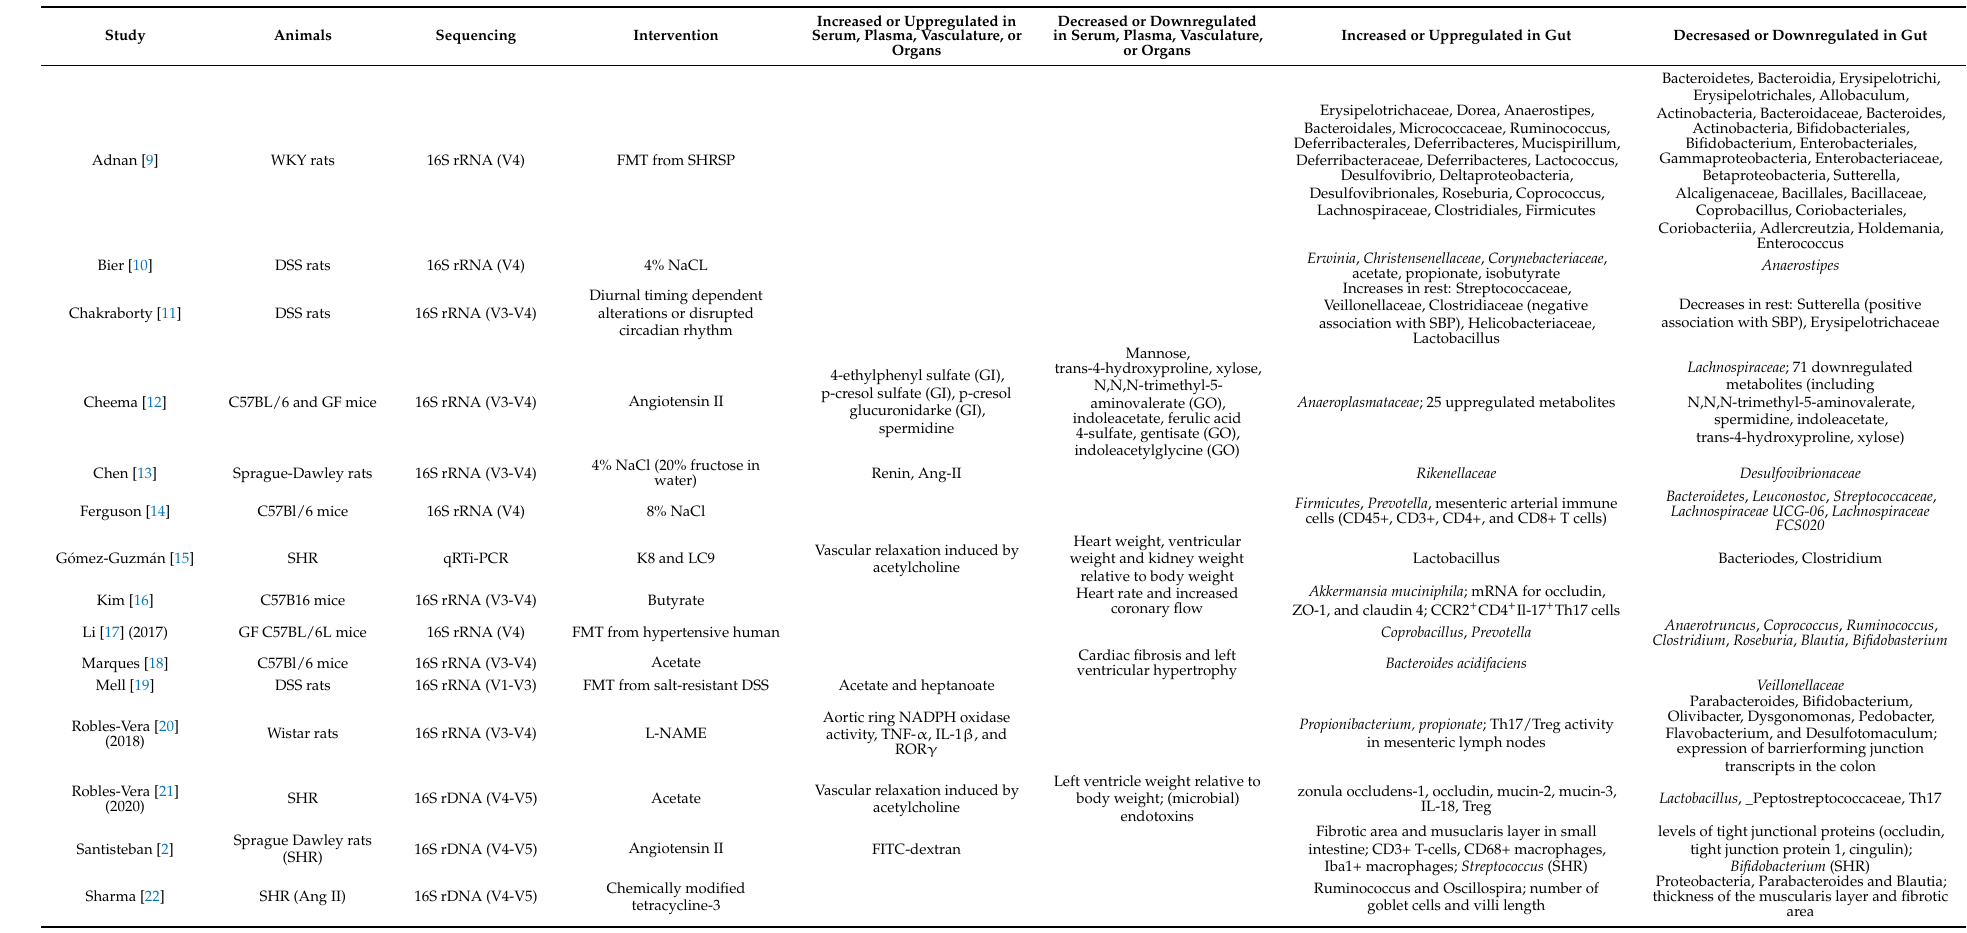
Table 1. The effect of rodent interventions to circulating metabolites, vasculature, gut wall, and gut